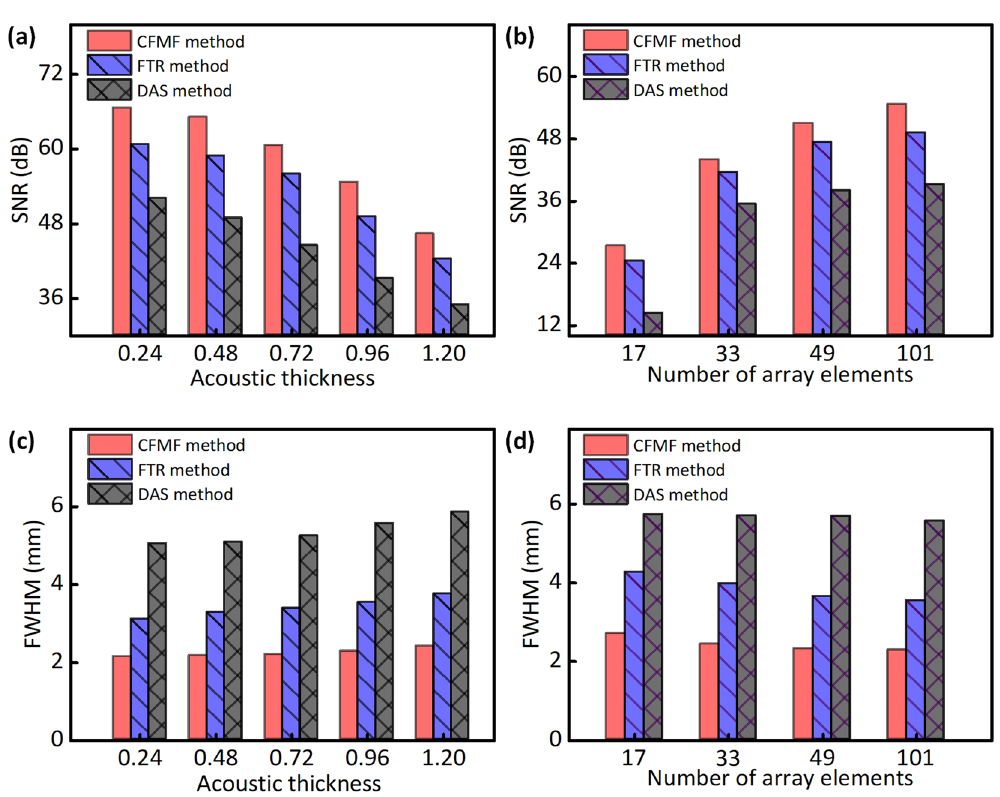
Figure 6. The comparison of the signal-to-noise ratio (SNR) and the FWHM between three different methods. ( a ) The SNR of three methods in the case of different scattering layer. ( b ) The SNR of three methods in the case of different array element number. ( c ) The average FWHM of three methods in the case of different scattering layer. ( d ) The average FWHM of three methods in the case of different array element